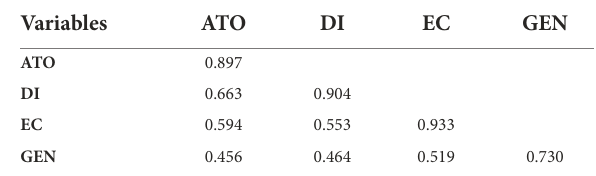
TABLE 4 Fornell-Larcker criterion analysis.